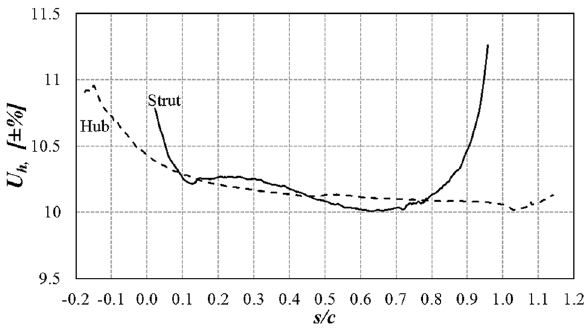
Fig. 12 Uncertainty of h along the hub centerline and midspan of the strut